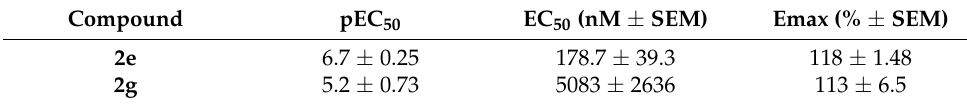
Table 4. G-protein enhancing effect of compounds 2e and 2f at the 5-HT 1A receptor.